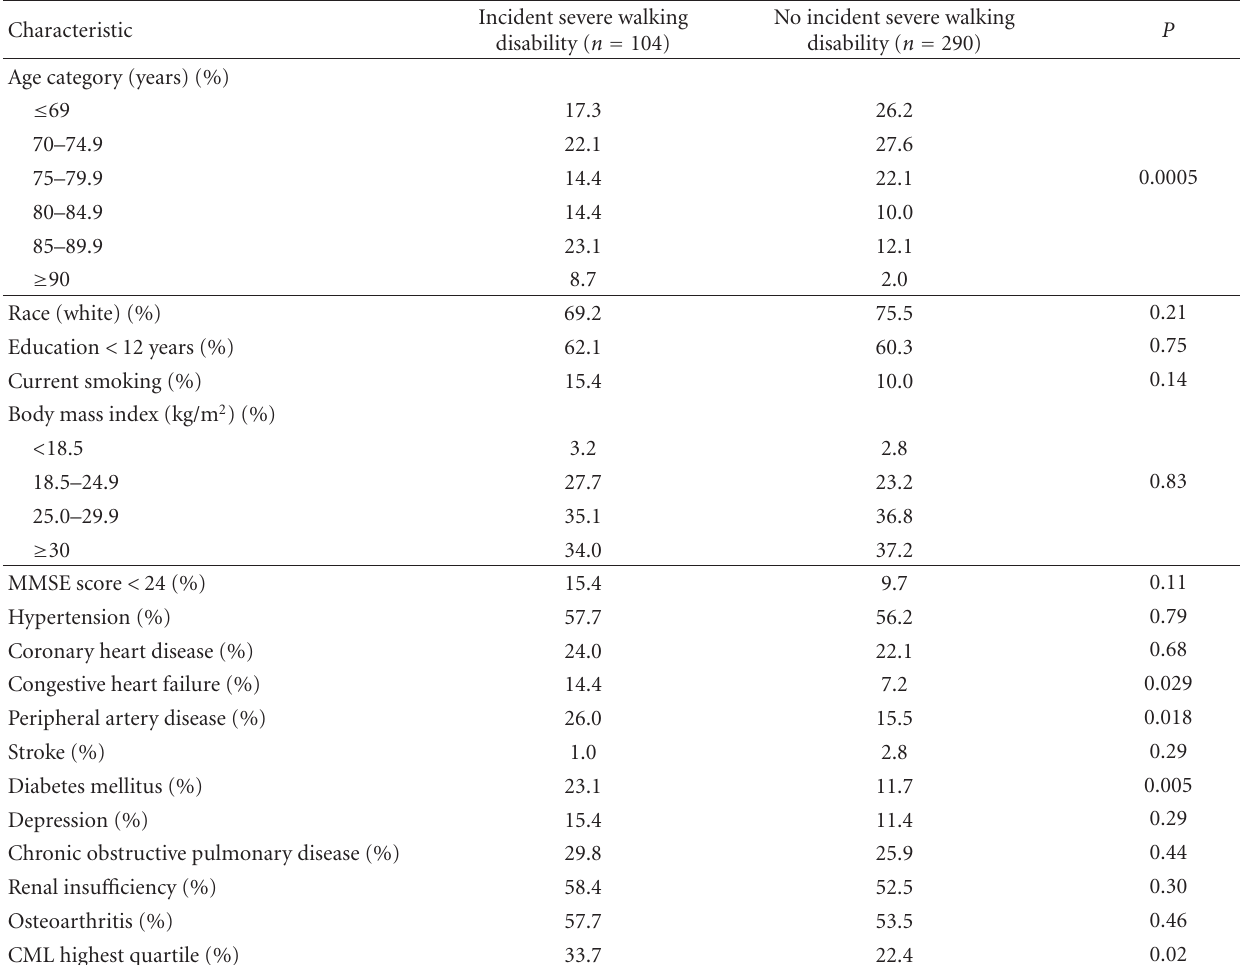
Table 1: Characteristics of women who developed and did not develop severe walking disability in the women’s health and aging study I ( N =